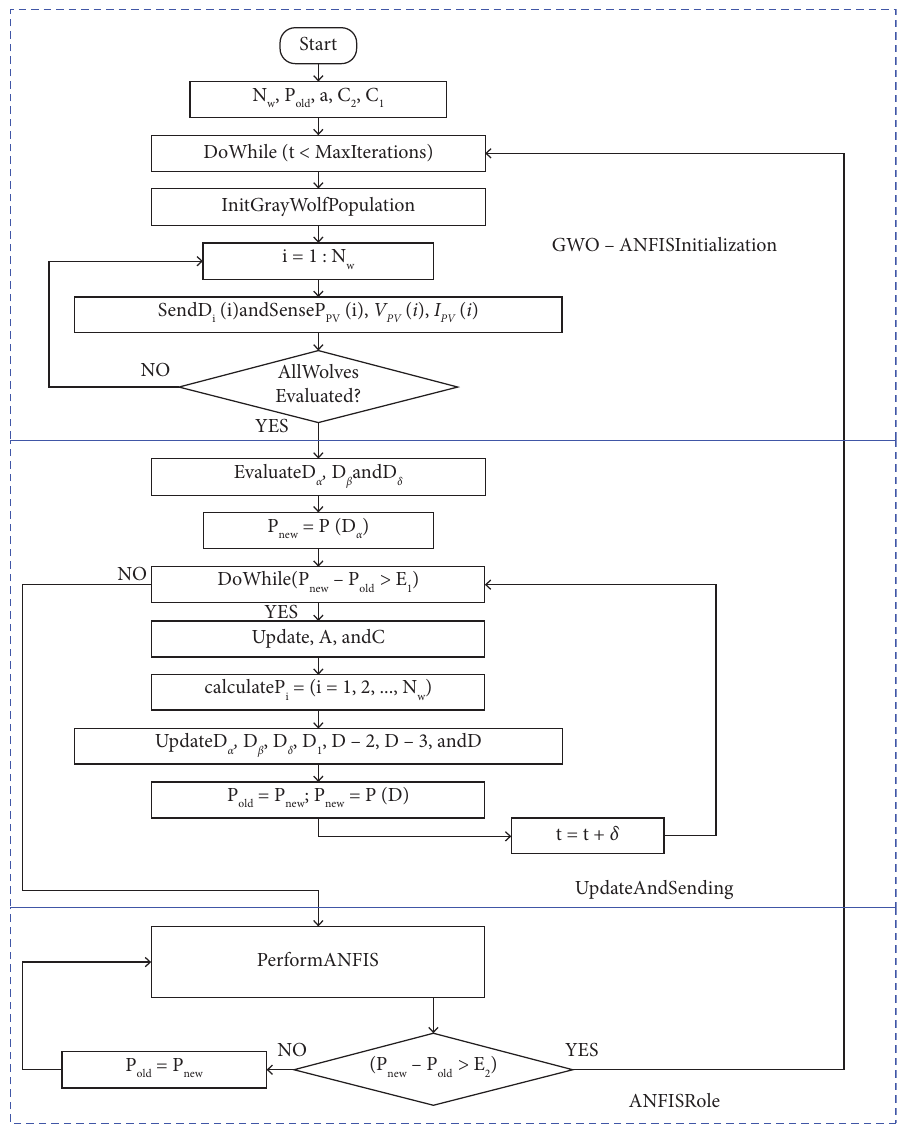
Figure 7: Flowchart of GWO-ANFIS based on PSCs